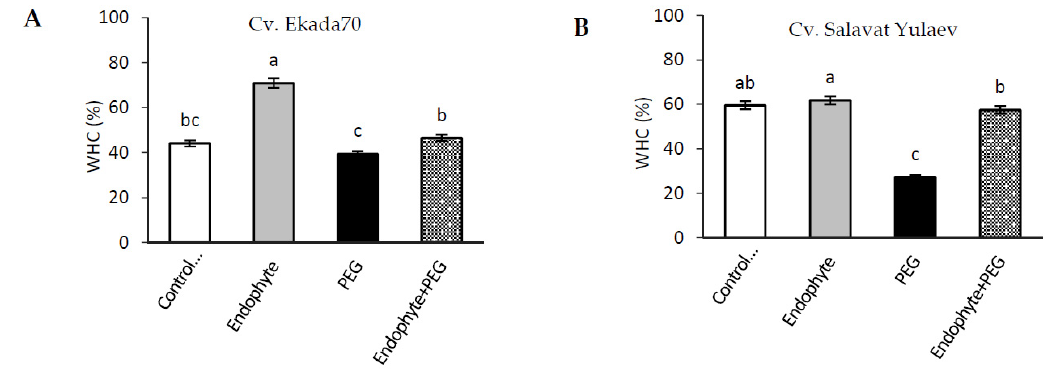
Figure 5. Effect of endophytic B. subtilis 10-4 (endophyte) on the water-holding capacity (WHC) in leaves of wheat seedlings of cv. Ekada70 ( A ) and cv. Salavat Yulaev ( B ) under normal and drought conditions (21 days after sowing of seeds). C—non-primed plants grown under normal